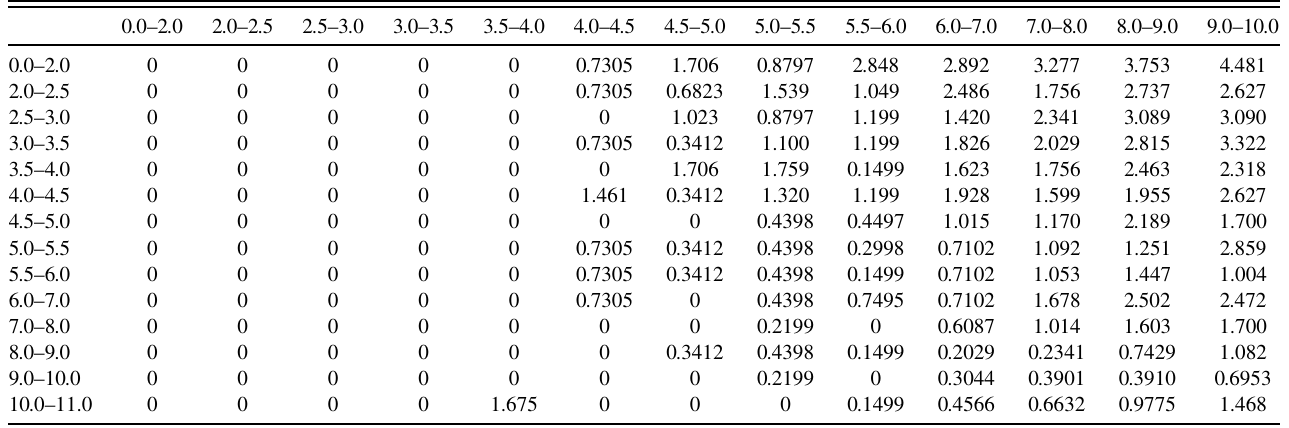
TABLE III. (cid:4) þ background from (cid:3) (cid:5) CC events (all values (cid:2) 10 (cid:1) 4